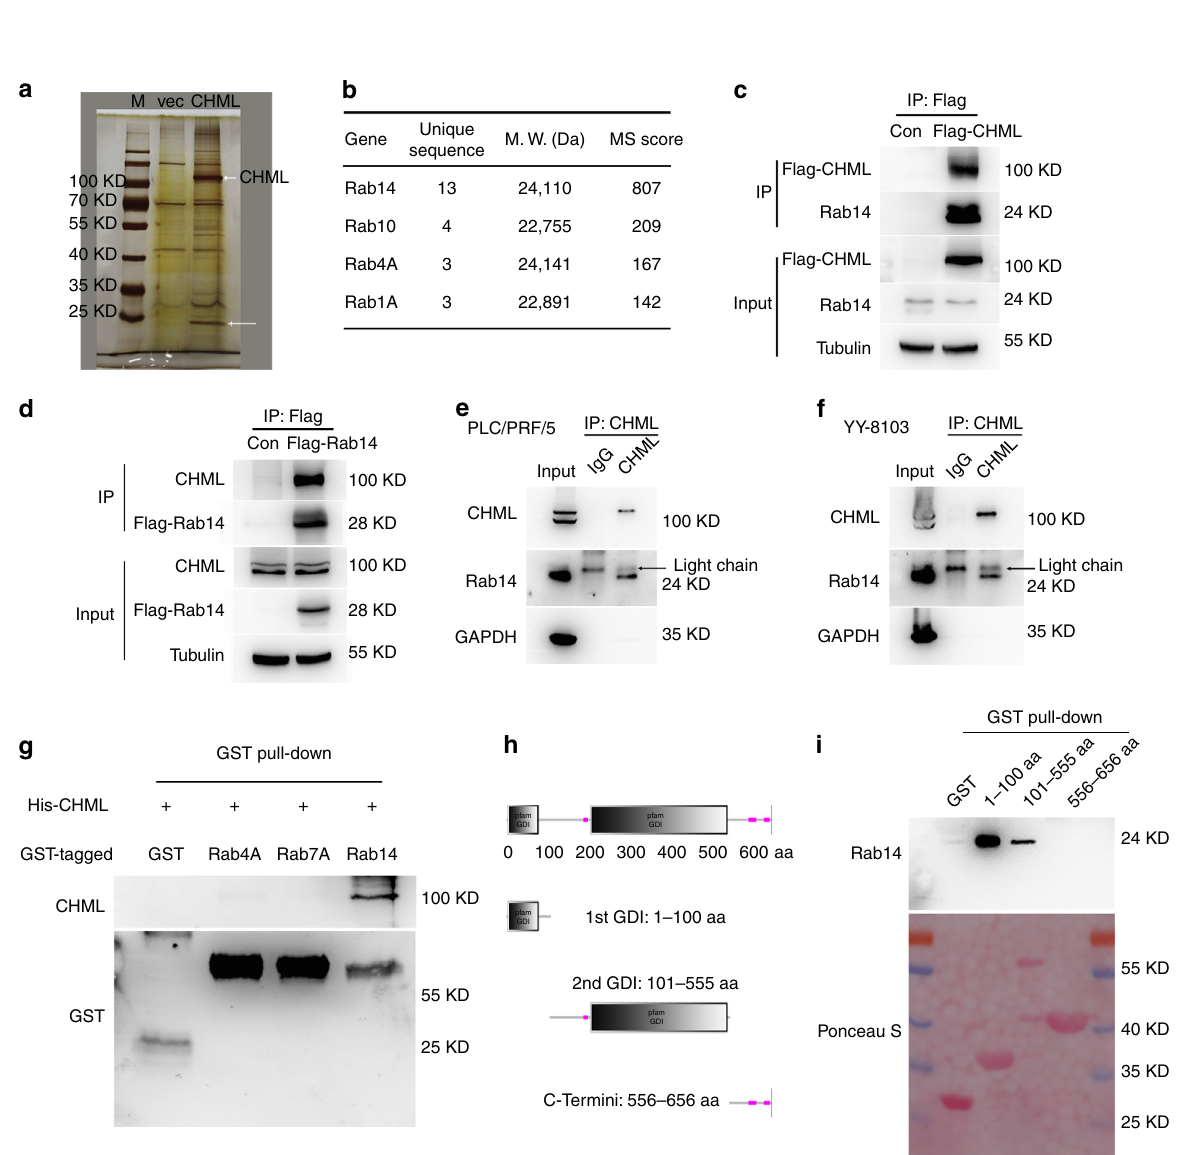
Fig. 4 CHML interacts strongly with Rab14. a silver stained gel shows differential bands between control and CHML sample. White arrow indicates differential band, the upper one indicates Flag-CHML. M marker, vec vector control. b Tandem mass spectrum analysis of target band. c , d Interaction between CHML and Rab14 was demonstrated by immunoprecipitation. 293T cells were transfected with Flag-CHML ( c ) or Flag-Rab14 ( d ). Immunoprecipitation was performed at 36 h post transfection with Flag antibody. e , f Western blot results showing endogenous CHML interacted with Rab14 in PLC/PRF/5 ( e ) and YY-8103 ( f ) cells. Black arrow indicates light chain. g In vitro interaction between CHML and Rab14. Puri fi ed 6xHis CHML was incubated with indicated GST fusion proteins, GST pull-down assay was conducted. h Graphic shows the domains in CHML protein. i In vitro interaction assay showing the two GDI domains interacted with Rab14. The truncated domains of CHML were fused with GST, and incubated with Rab14, followed by